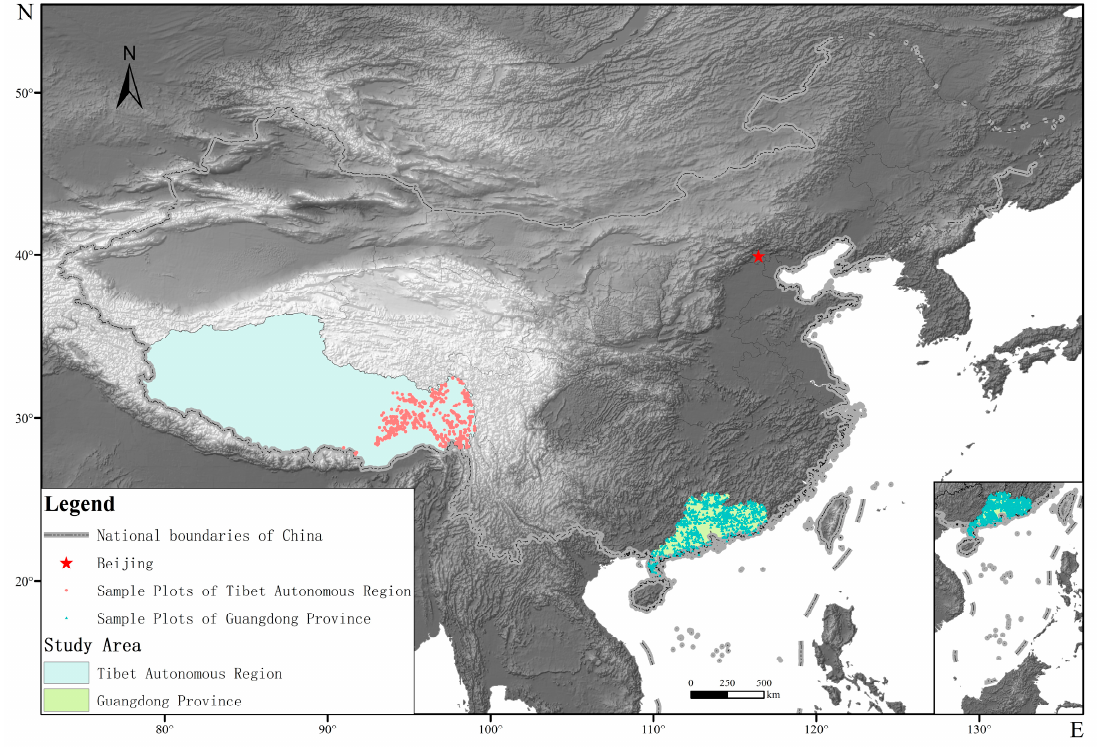
Figure 1. Location of the study area consisting of Guangdong province and Tibet autonomous region and spatial distribution of corresponding permanent sample plots.